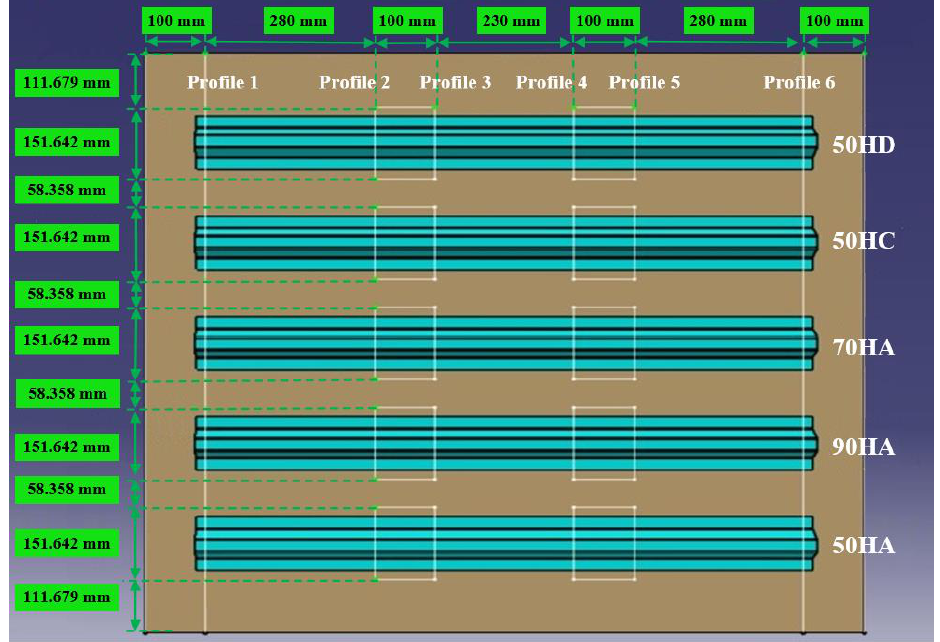
Figure 6. Sampling positions distribution.